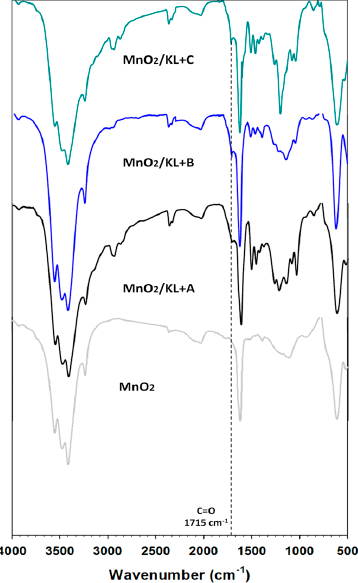
Figure 8. FTIR spectra of manganese oxide and MnO 2 /lignin hybrid materials based on activated biopolymer with using selected ionic liquids: [C 4 im][HSO 4 ] (MnO 2 /KL+A), [Et 3 NH][HSO 4 ] (MnO 2 /KL+B) and [C 4 C 1 im][MeSO 3 ] (MnO 2 /KL+C).